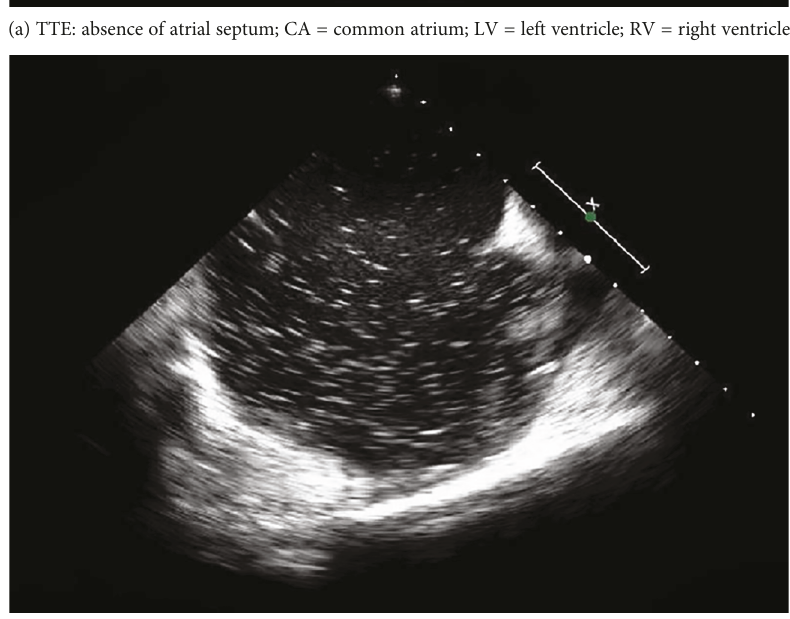
Figure 1: Echocardiography images revealing common atrium. (a) TTE: absence of interatrial septum. (b) TEE: positive bubble